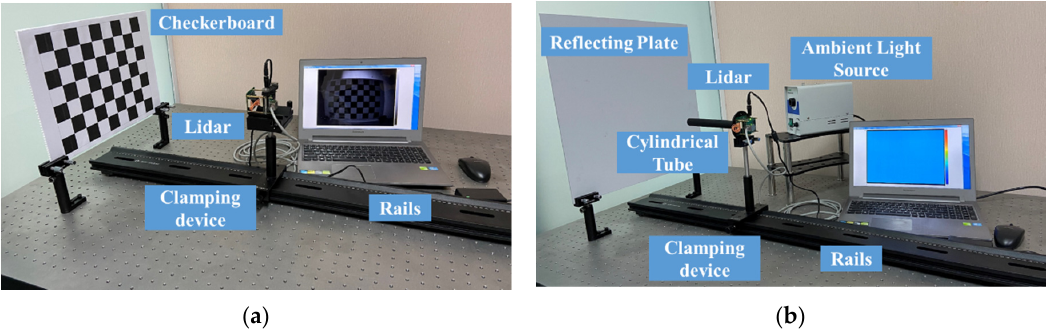
Figure 9. Experimental settings. ( a ) The grayscale image calibration system and ( b ) the depth image calibration system.